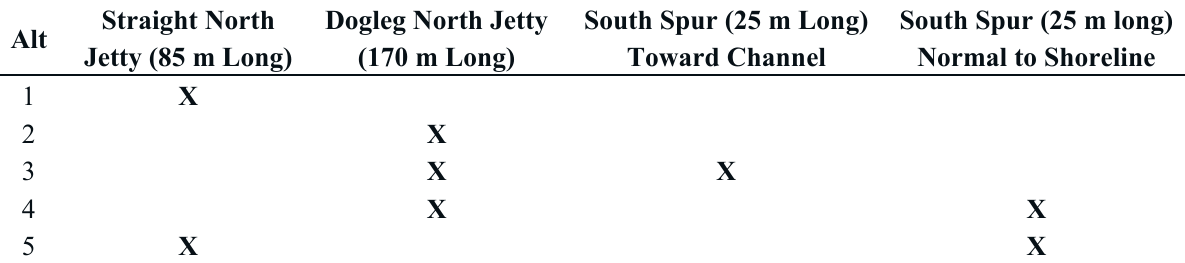
Figure 5. Depth color contours of the existing western entrance channel and Alts 1 to 5. Table 1. Structural features of